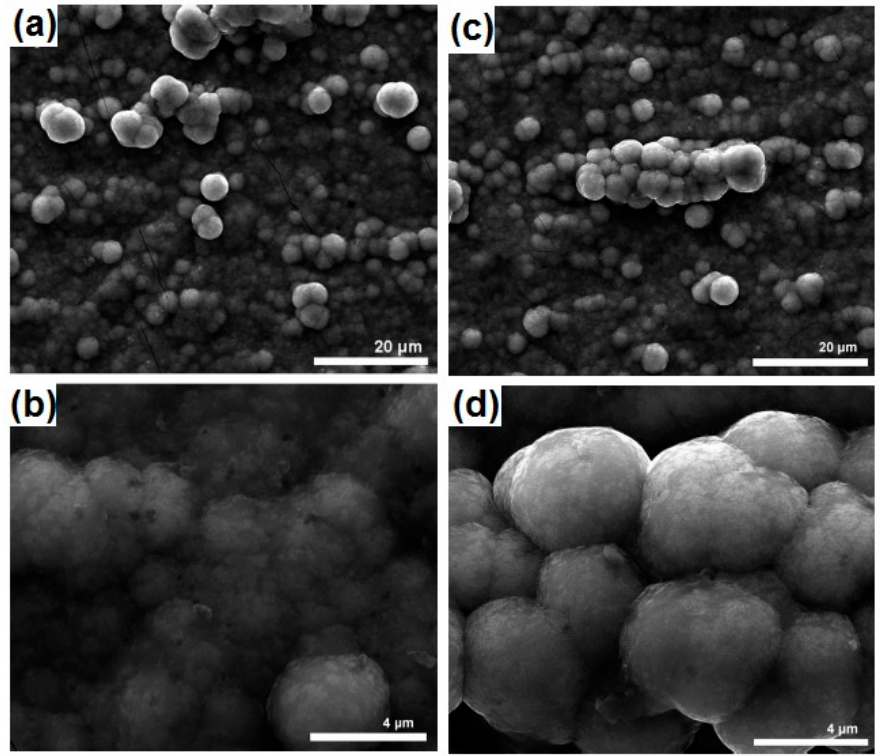
Figure 5. Low and high magnification SEM images of the AlCrCuFeMnNi films deposited at ( a , b ) − 2.1 V for 90 min, and ( c , d ) − 2.5 V for 90 min [73]. Copyright 2015